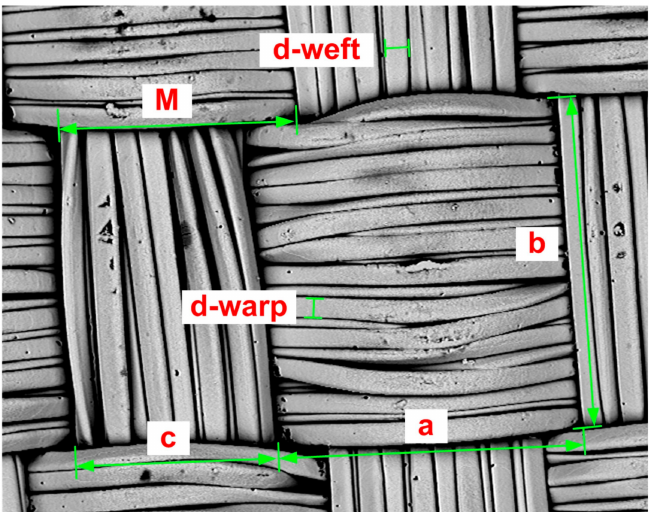
Figure 9. Measurement of input parameters for the theoretical length of the warp and weft calculation for the sample